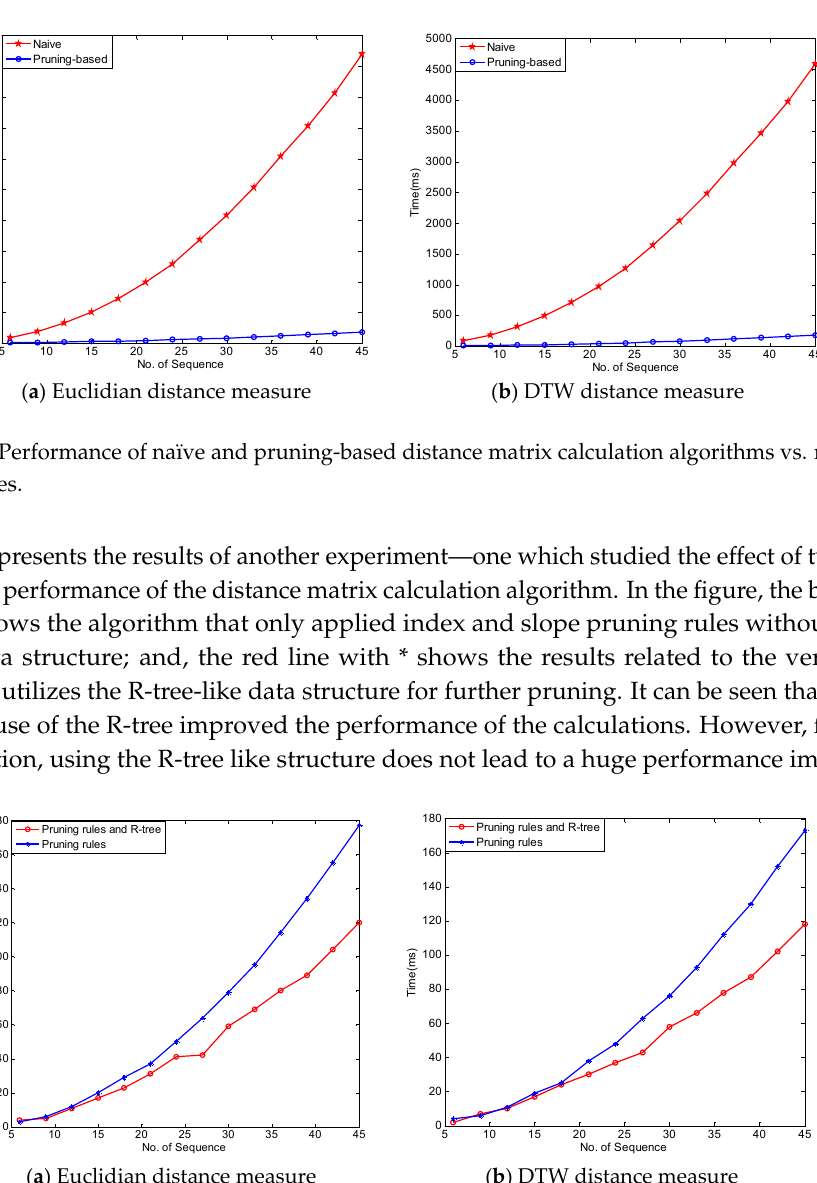
Figure 9. Performance of FindCandPatterns Algorithm . Sensors 2017 , 17 , 1076